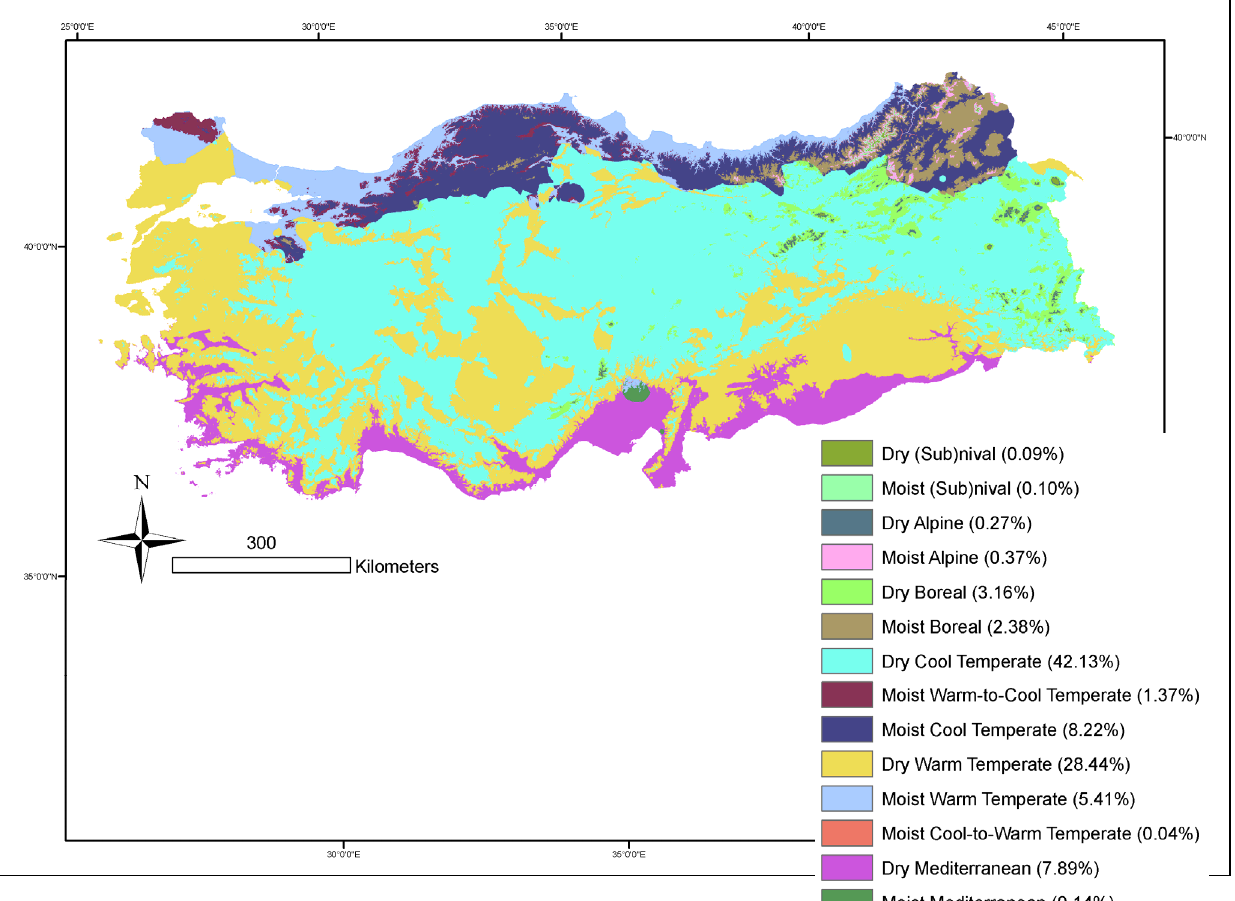
Figure 2. Spatial distribution and extent (% of total area) of major biogeoclimatic zones in